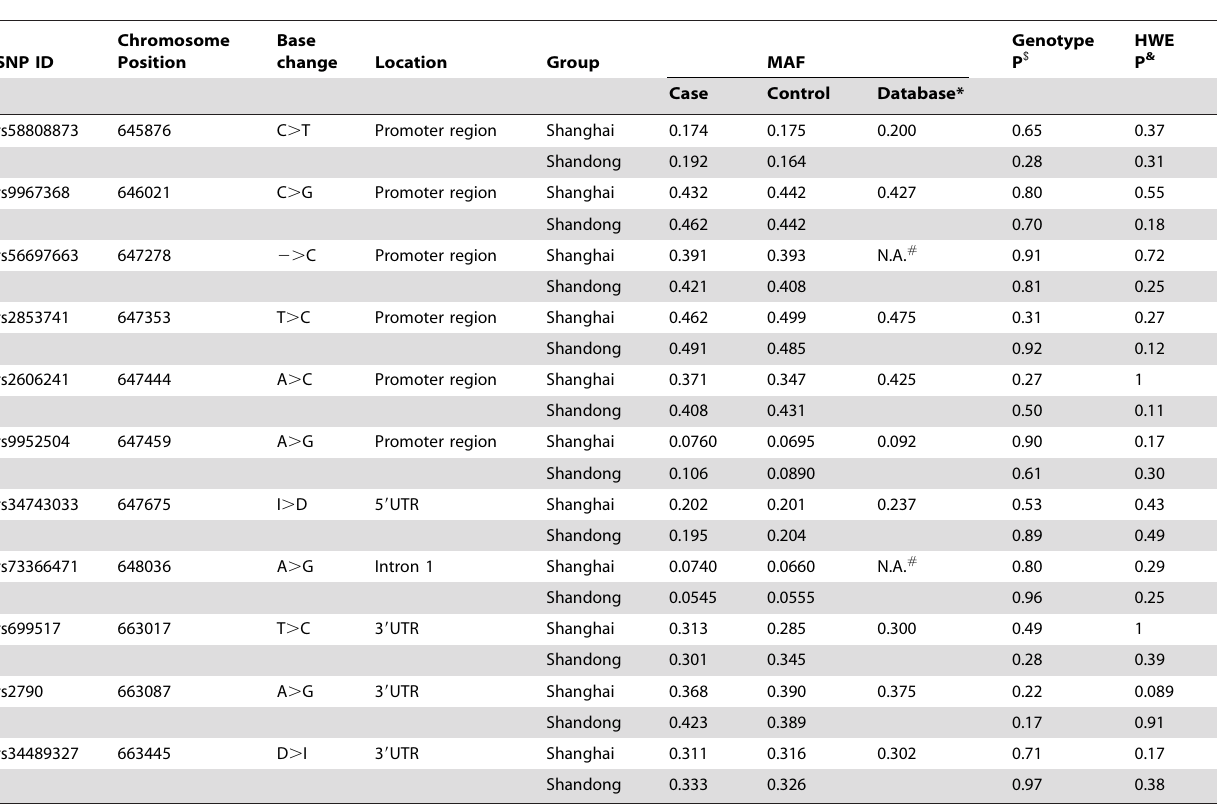
Table 2. The allelic and genotype frequency of the TYMS polymorphisms in CCSD patients and controls.